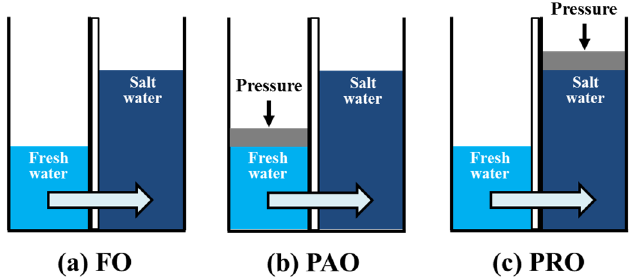
Figure 1. Schematic of osmosis-driven processes: ( a ) forward osmosis (FO); ( b ) pressure-assisted osmosis (PAO); and ( c ) pressure-retarded osmosis